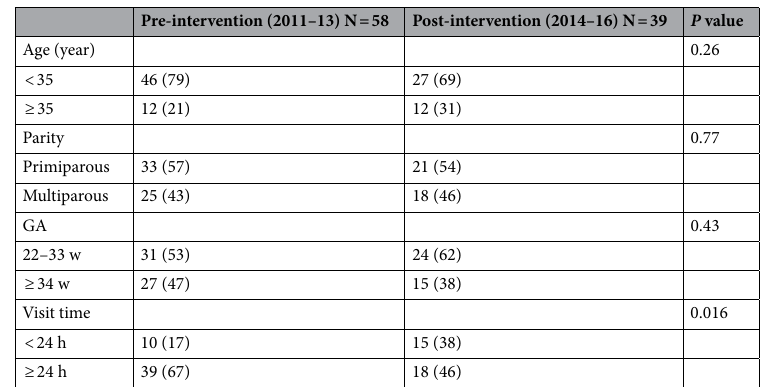
Table 2. Among DFM population. GA gestational age, DFM decreased fetal movement. Visit time indicates the time to visit healthcare provider after maternal perception of DFM. The number of stillbirths without accurate visit time after perceiving DFM were excluded. Data are n (%).